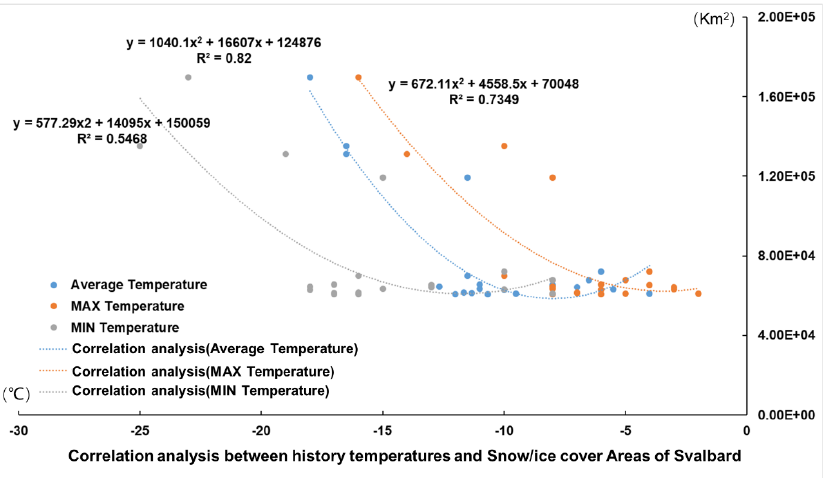
Figure 12. Correlation analysis between historical temperatures and snow/ice cover areas of Svalbard, Arctic region.